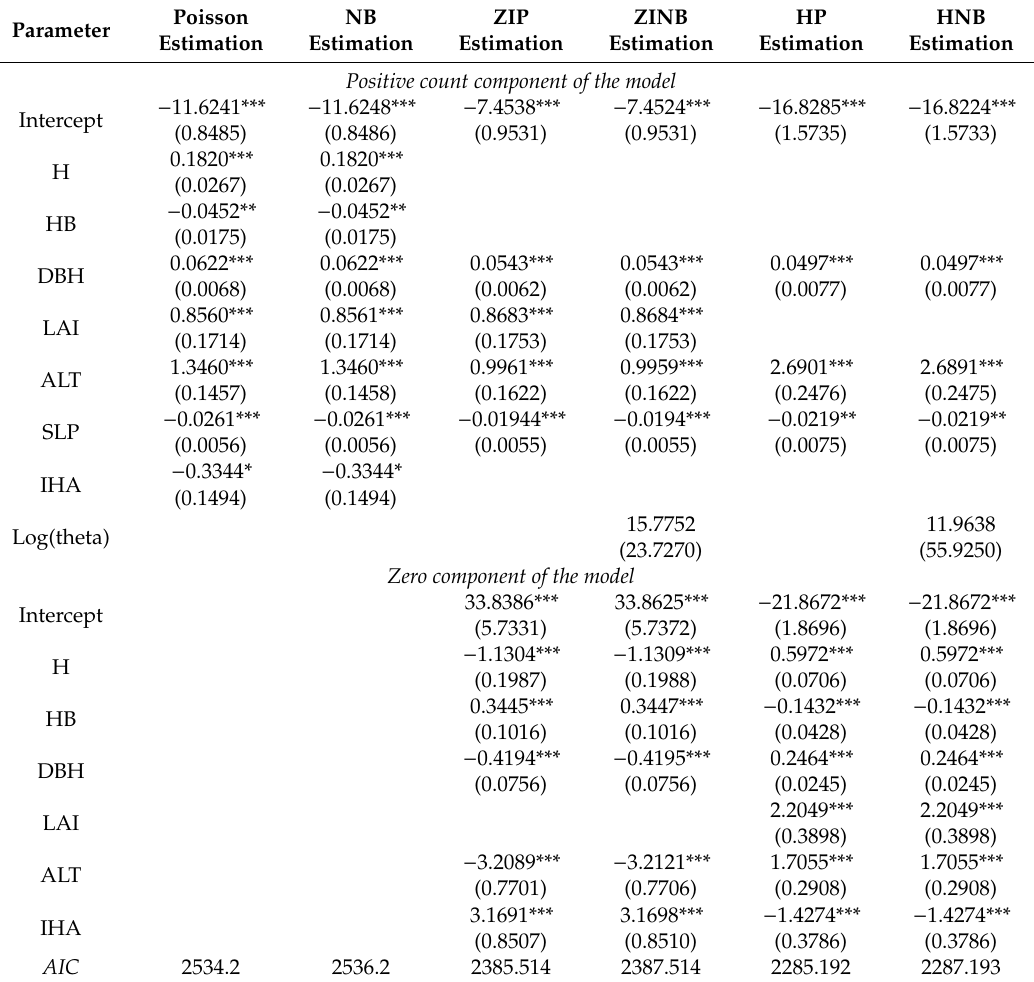
Table 3. Parameter estimates and fit statistics of Poisson, Negative binomial (NB), Zero-inflated Poisson (ZIP), Zero-inflated negative binomial (ZINB), Hurdle-Poisson (HP), and Hurdle negative binomial (HNB) models for abundance of epiphytic